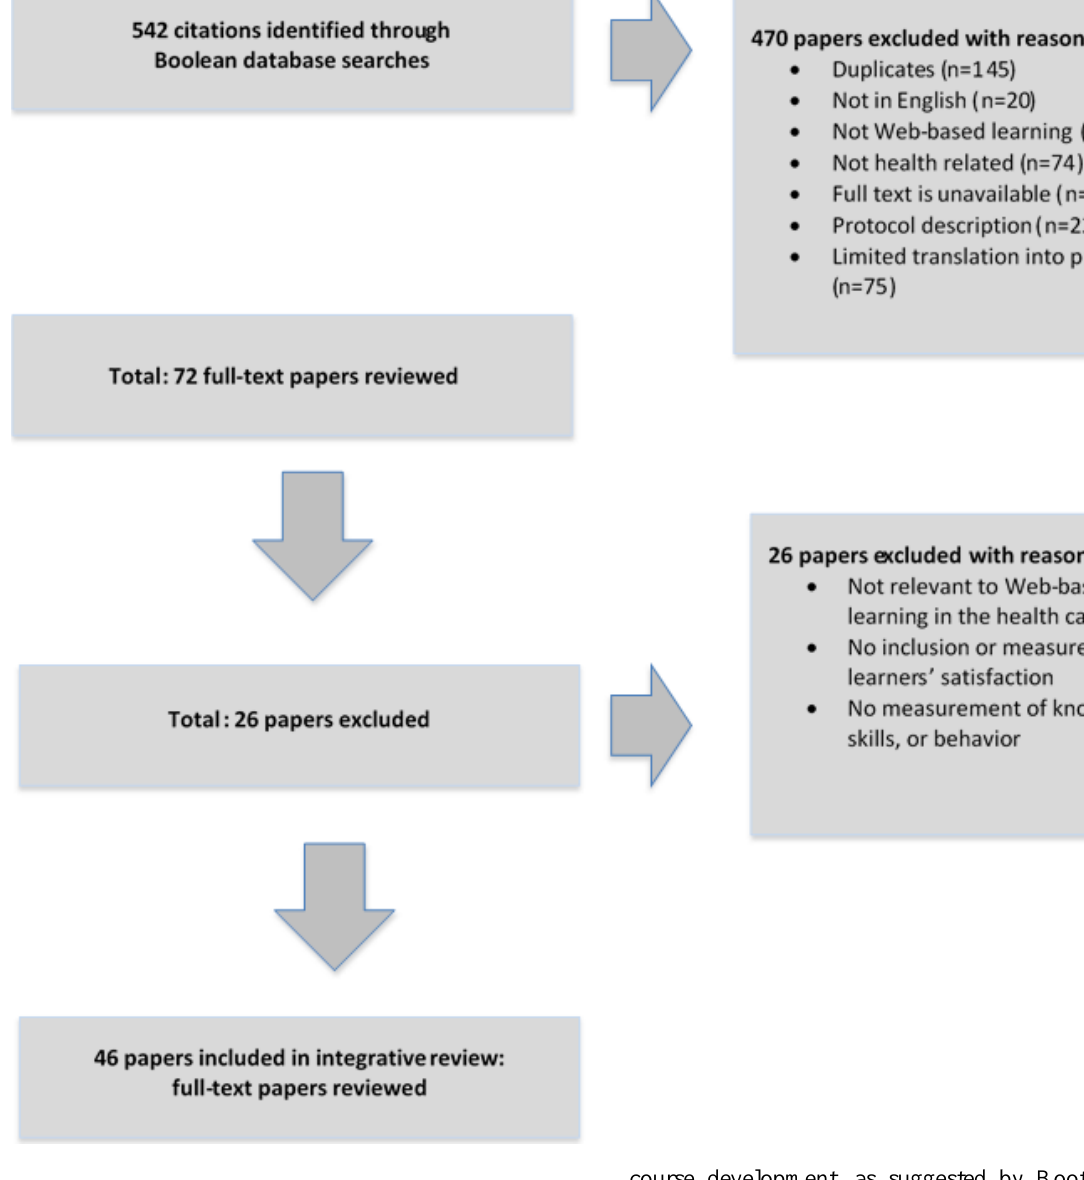
Figure 1. Flow diagram of the systematic review